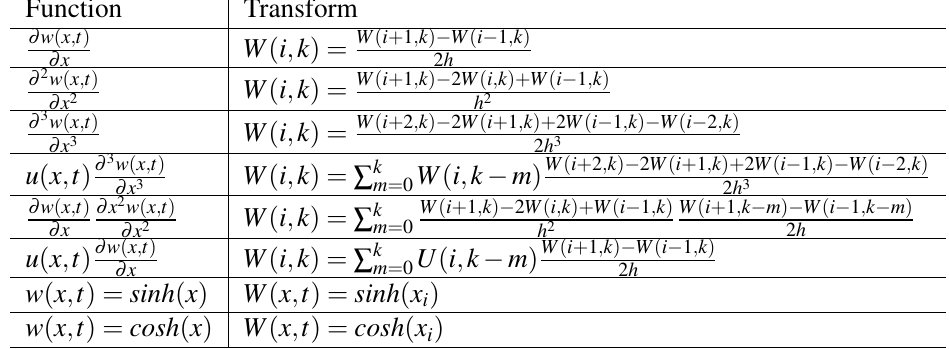
Table 2 Some properties of central difference and differential transform based on x − variable.